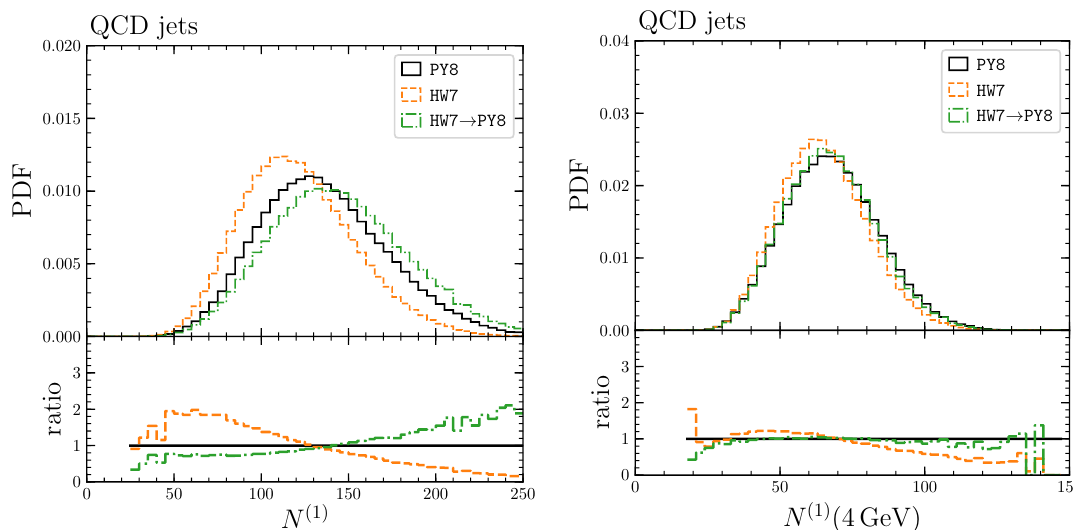
Figure 20. The N (1) and N (1) (4 GeV) distributions of PY8 , HW7 , and reweighted HW7